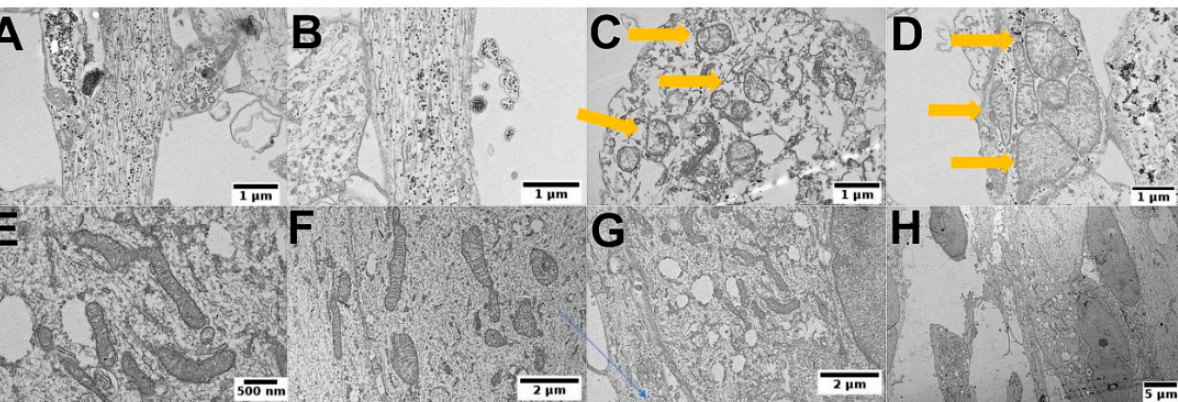
Figure 8. The cellular fate of PEI-MSN in the treated BT-12 (cultured in stem cell conditions) GSCs after 72 h. ( A , B ) Endosomally escaped PEI-MSNs can be observed widespread within the cells, tandem with loss of structural integrity of the cells. ( C , D ) Abnormalities in the mitochondrial morphology, mitochondrial swelling, and rupture of the cristae (arrows). TEM images of control BT-12 (cultured in stem cell conditions) GSCs without PEI-MSNs treatment. ( E , F ) A close overview of the intact mitochondrial structure. ( G ) Empty lysosomes and normal ultrastructure of BT-12 GSCs (cultured in stem cell conditions). ( H ) Overview of a control cell.